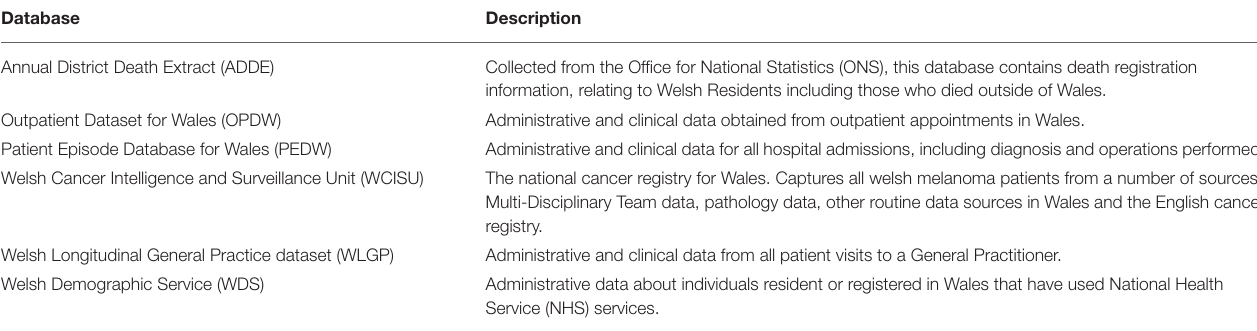
TABLE 1 | List of databases used for data linkage and their descriptions.